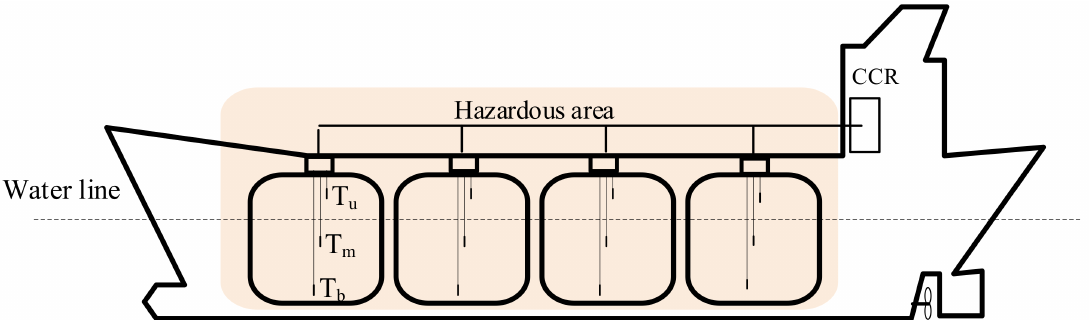
Figure 8. The temperature measurement of liquefied gas in tanks, CCR—Cargo Control Room, T b , T m —sensor in bottom and middle of tank to measure temperature of liquefied gas, T u —upper sensor to measure temperature of